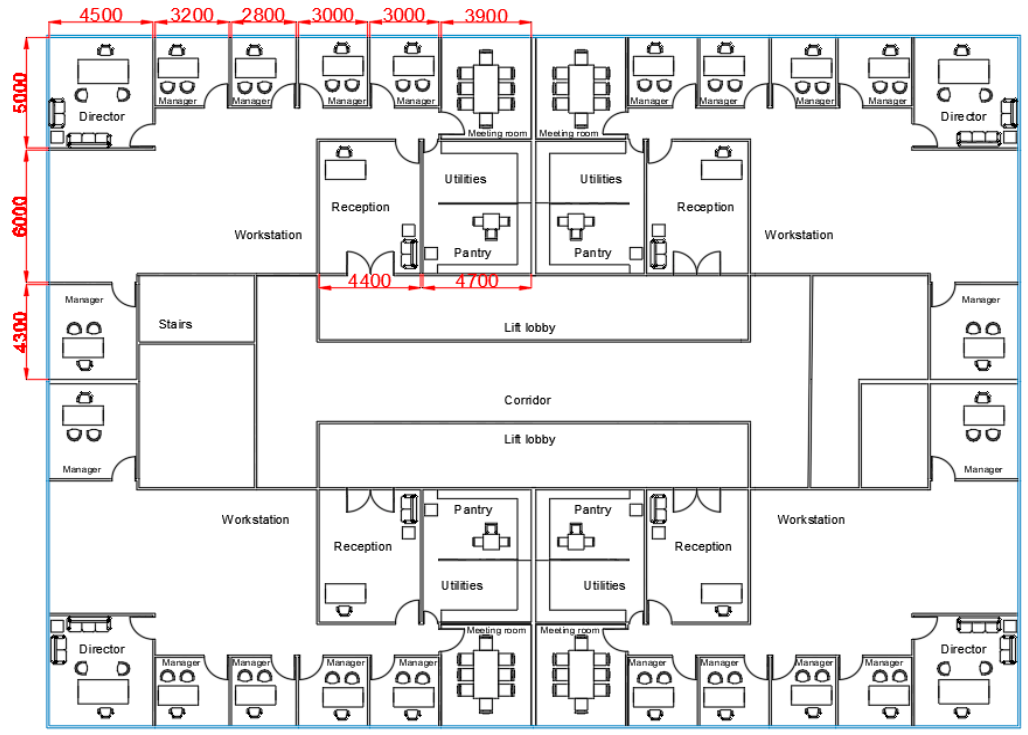
Figure 1. Floor plan (in mm).